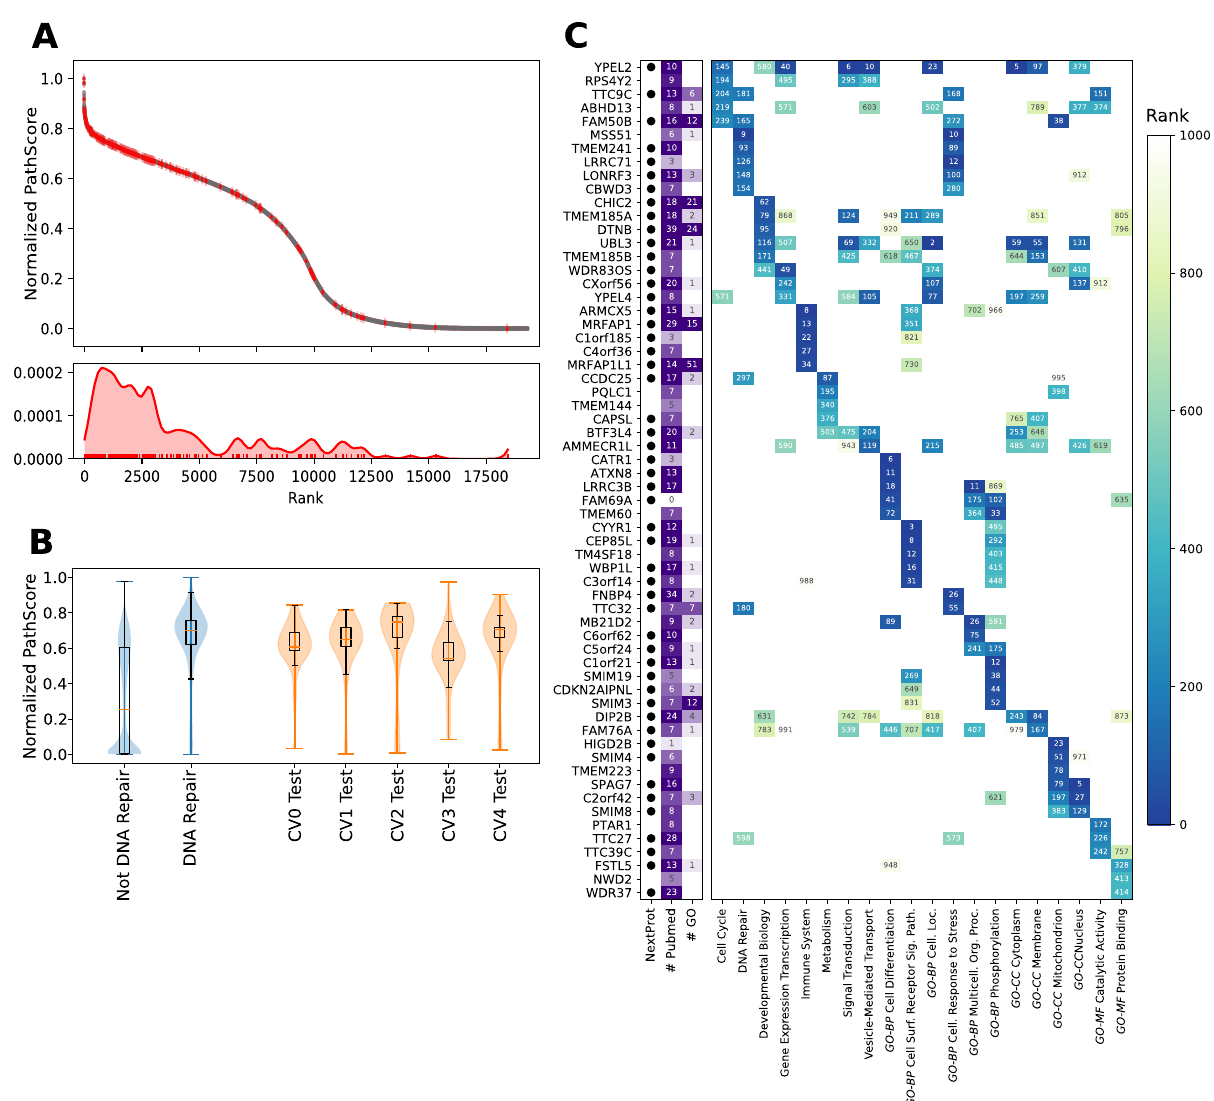
Fig. 4 Assigning genes with unknown functions to pathways types. PathScore is a random-walk based measure identifying the importance of genes in a given network. The PathScore is calculated per label for all genes and prioritizes genes not known to belong to that pathway (gray) having equivalent or higher PathScores than known genes (red). Shown for the pathway type DNA repair ( A ). The PathScore is higher for genes belonging to a speci fi c pathway and generalizes genes in the pathway found only in the test set. Shown for DNA repair ( B , 240 known genes). Similar performance metrics appear in Supplementary Figs. 14-15 for the rest of the pathway types considered. The boxplot extends from the lower to upper quartile values of the data, with an orange line at the median. Whiskers denote 1.5 times the interquartile range. The top fi ve less studied genes (having no function in UniProt in addition to low number of Pubmed mentions or appearing in NextProt uncharacterized genes set) are picked out for each pathway type and presented with their descending PathScore rank for the pathway types from Reactome and GO ( C ). Genes are annotated by whether they appear in the uncharacterized gene set in NextProt (by a dot to denote appearance in the list), number of Pubmed mentions ( “ # Pubmed ” ) and number of associated GO terms ( “ # GO ” ). GO — gene ontology. Source data are provided as a Source Data fi